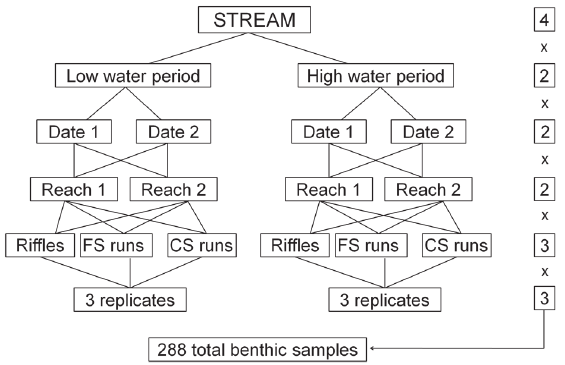
Figure 2 - Sampling design applied in each of the four study streams. The numbers on the right refers to the 4 streams, 2 reaches, 2 hydrological periods, 2 dates, 3 habitats and 3 replicates that were considered in a nested design in the